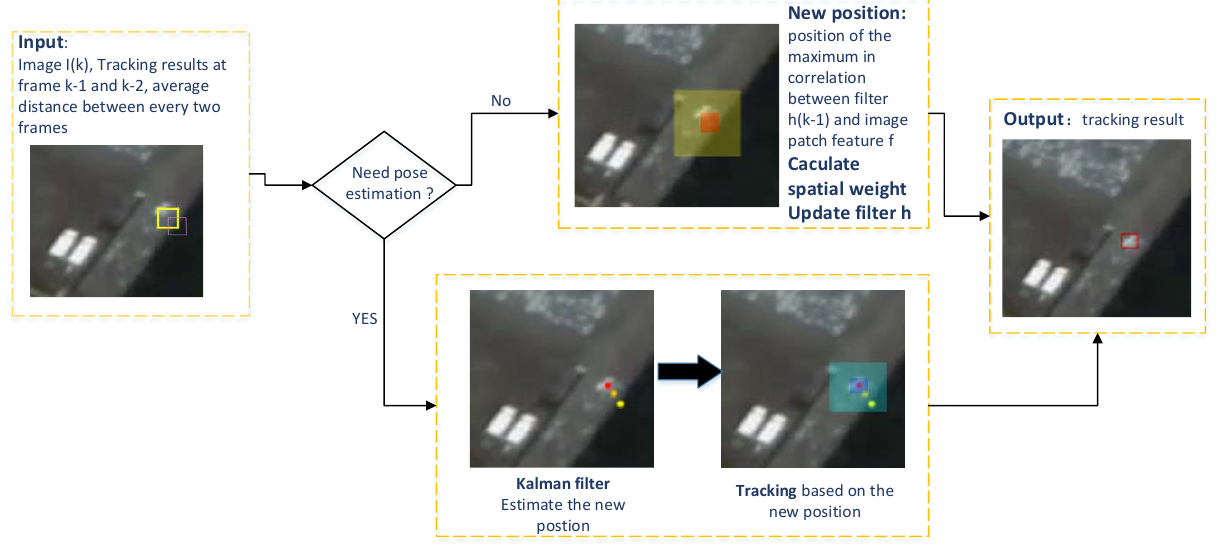
Figure 1 Flowchart of the proposed approach. We introduce the spatial weight to restrict the DCF filter and do the pose estimation through Kalman filter when the tracking result stay at one